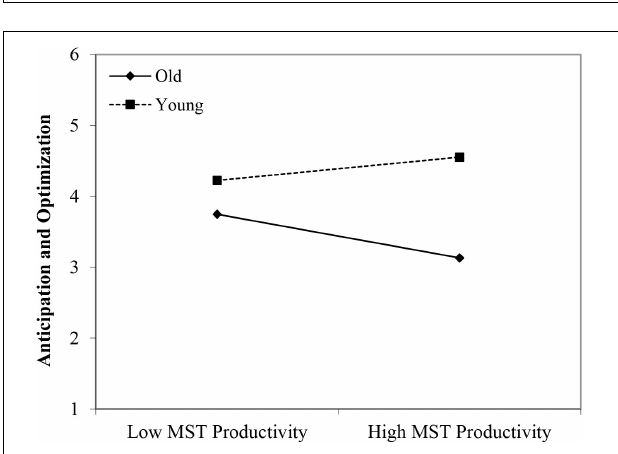
( β = 0.40, p < 0.05); and middle-aged workers ×